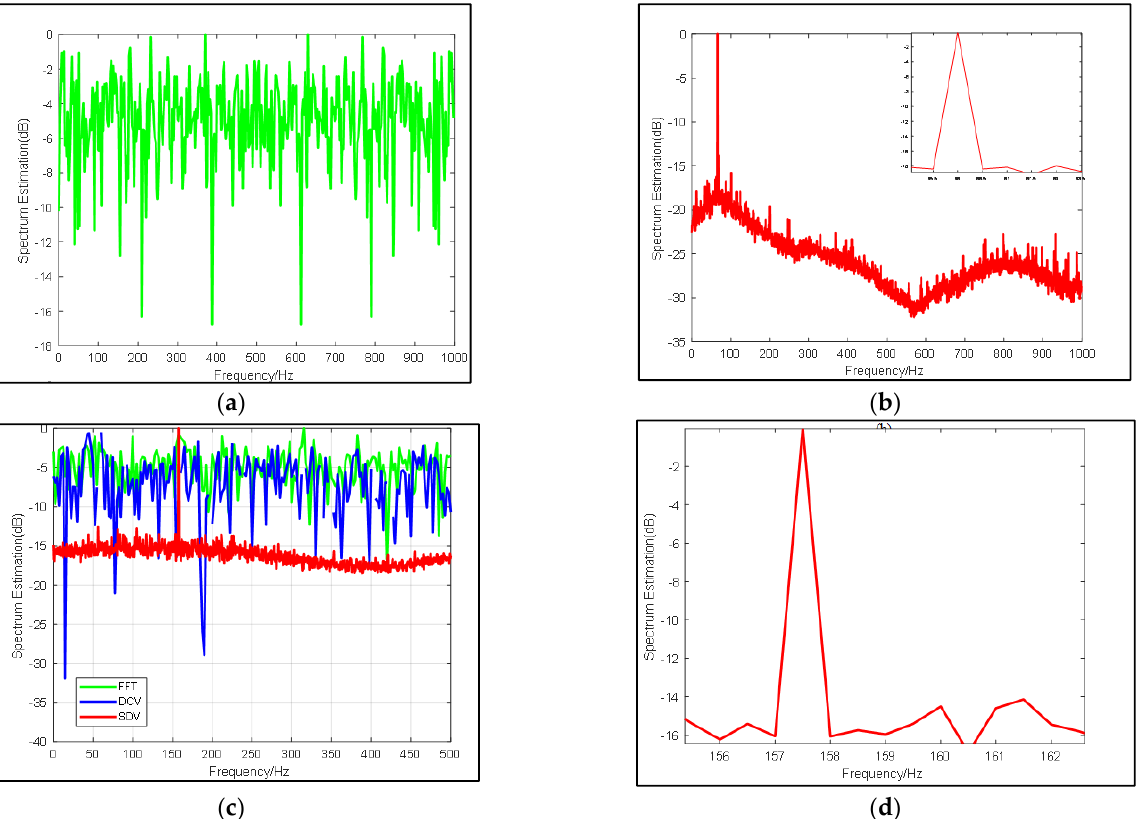
Figure 5. ( a ) Results from FFT under − 26 dB, ( b ) Results from SDV using the same data with ( a ), ( c ) Comparison of frequency spectrum estimation results from FFT (blue line), DCV (green line) and SDV (red line) under SNR = − 26 dB, ( d ) Zoom in on the spike of ( c ).